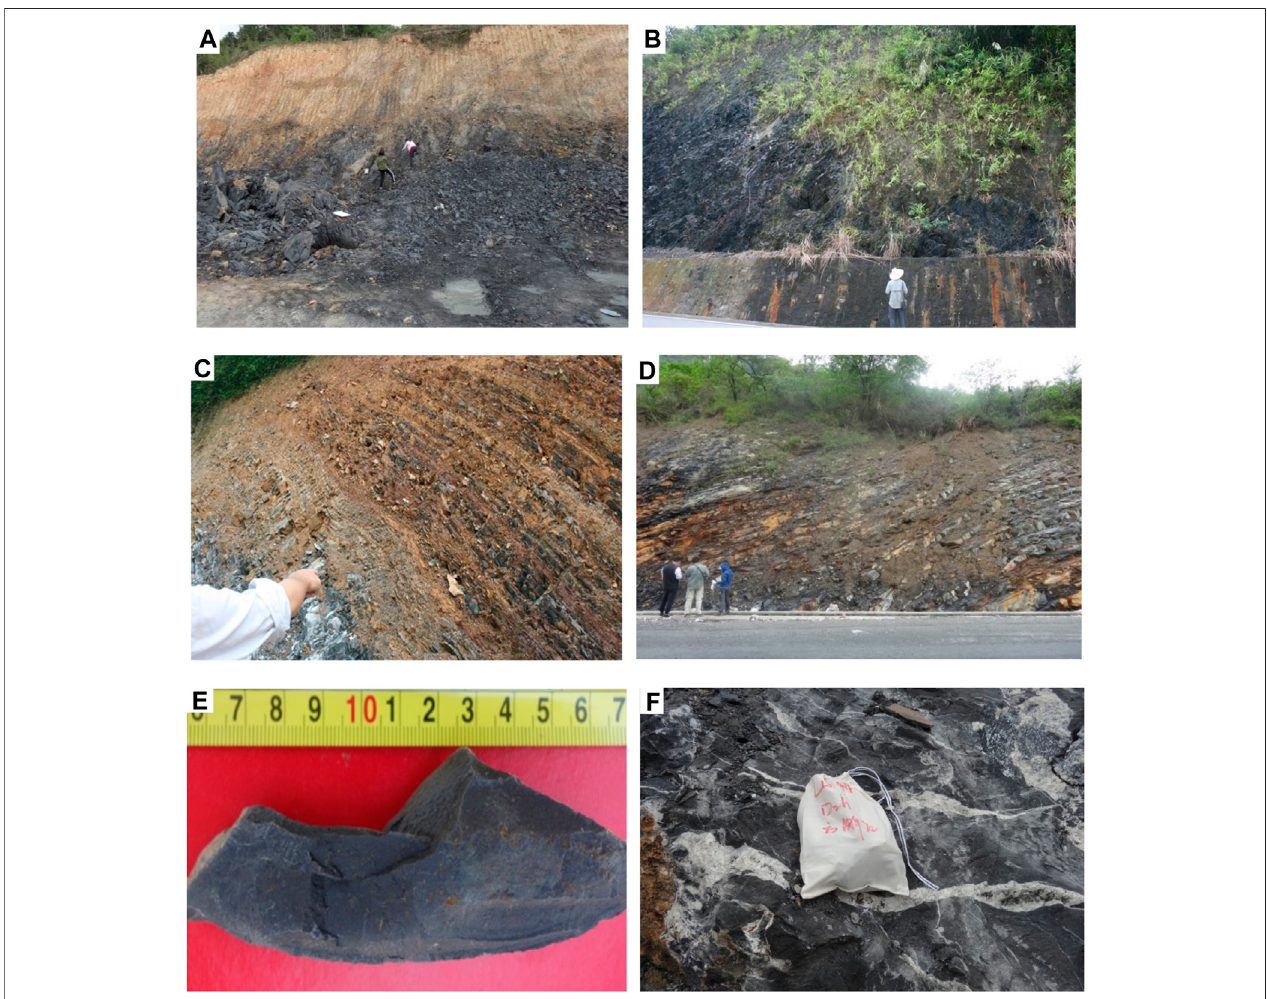
FIGURE 2 | Lithologic characteristics of shale in different layers. (A) Carbonaceous shale of the Devonian Huohong Formation (Chuangjing pro fi le in Luodian). (B) Carbonaceous shale containing slub stone of the Devonian Huohong Formation (Chuangjing pro fi le in Luodian). (C) Siliceous shale and carbonaceous shale of the Dawuba Formation (Chuangjing pro fi le in Luodian). (D) Limestone intercalated with carbonaceous shale of the Nandan Formation (Fengting pro fi le in Luodian). (E) Carbonaceous shale of the Devonian Huohong Formation (Chuangjing pro fi le in Luodian). (F) Shale of the Huohong Formation, development of fracture in the limestone interlayer (Chuangjing pro fi le in